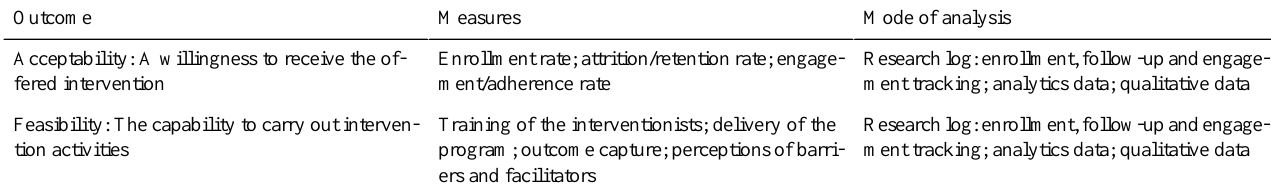
Table 4. Description of implementation outcomes.